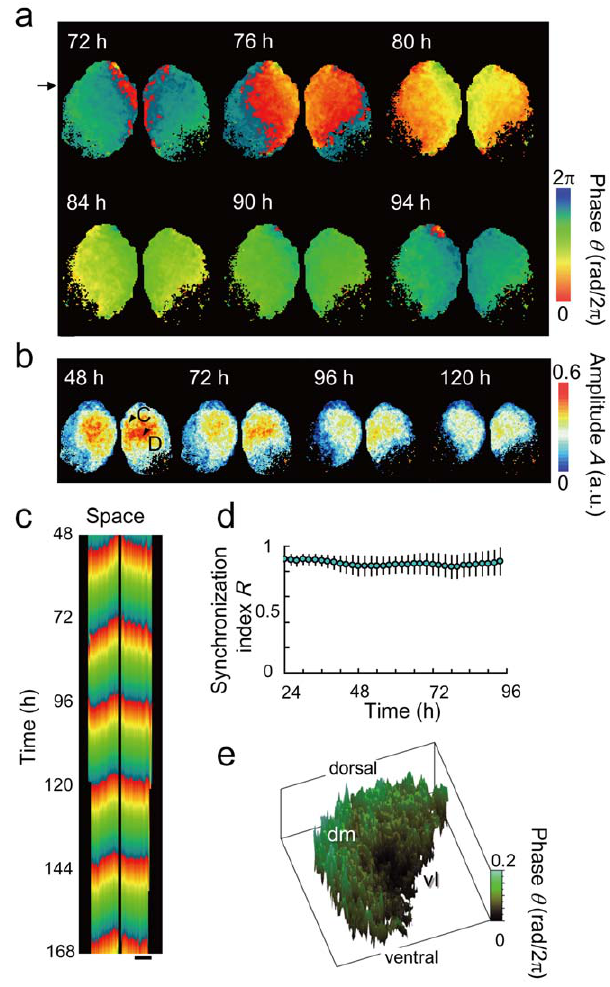
Figure 2. Spatiotemporal variation of the phase and amplitude of a cultured SCN slice. (a) Time evolution of the phase h . (b) Time evolution of the amplitude A . The elapsed time from the beginning of the measurement is indicated in each image. (c) Space-time plot of phase h on the horizontal line indicated by the arrows in Fig. 2a. The scale bars correspond to 200 m m length. (d) Synchronization index R computed by Eq. [5] for four different SCN slices, indicating strong synchronization among SCN neurons. Error bars indicate the standard deviation. (d) Three-dimensional representation of the phase pattern with spatial fluctuation on the right-side SCN slice at t =99.5